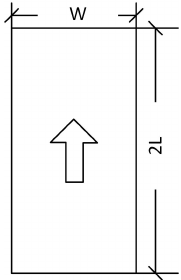
Figure 4. Illustration of an RRB.